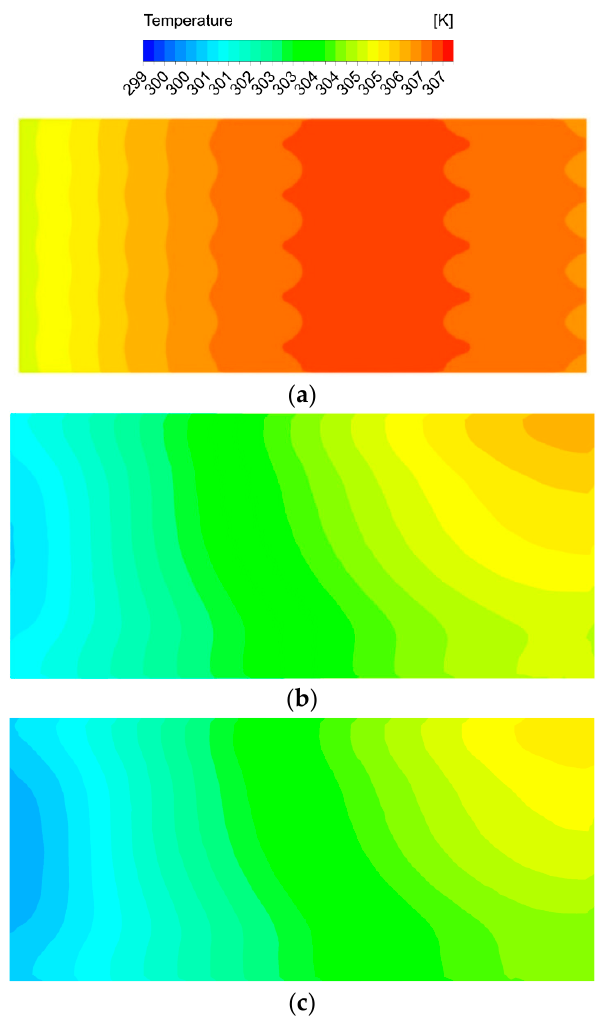
Figure 13. The bottom wall temperature contour of ( a ) DL-T, ( b ) DL-M and ( c ) DL-IM.